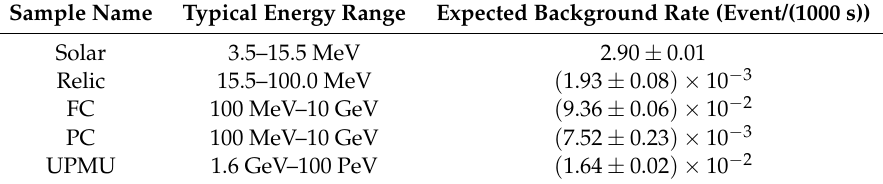
Table 3. Number of expected background events within a search window of 1000 s for all samples. In order to estimate the rate, we used 306.1 days of SK data for the solar sample, 2887 days for the relic sample, and 2976 days for the fully-contained (FC), partially-contained (PC), and upward-going muon (UPMU) samples